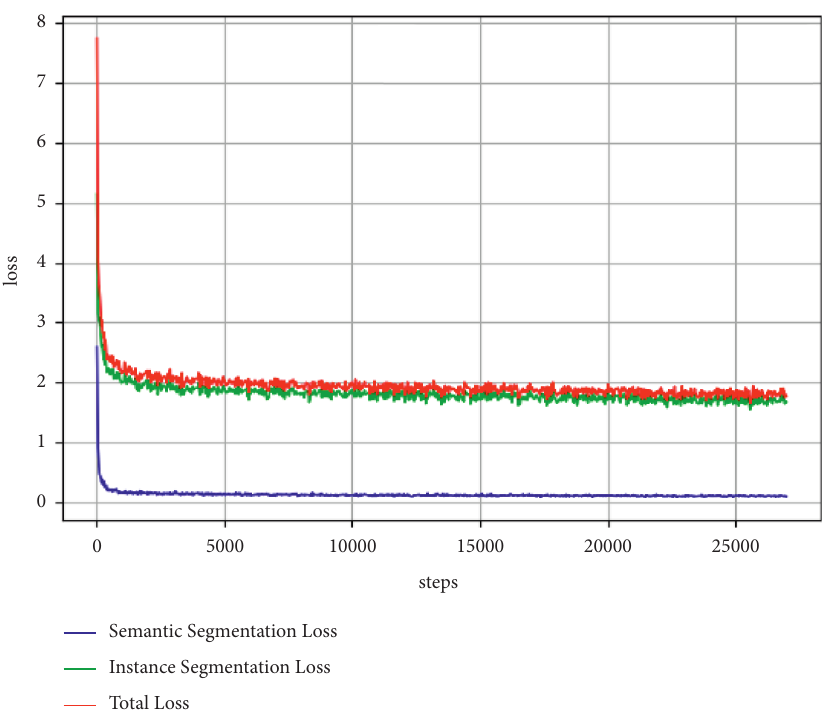
Figure 7: Loss change of panoramic segmentation. Table 1: Panoramic segmentation